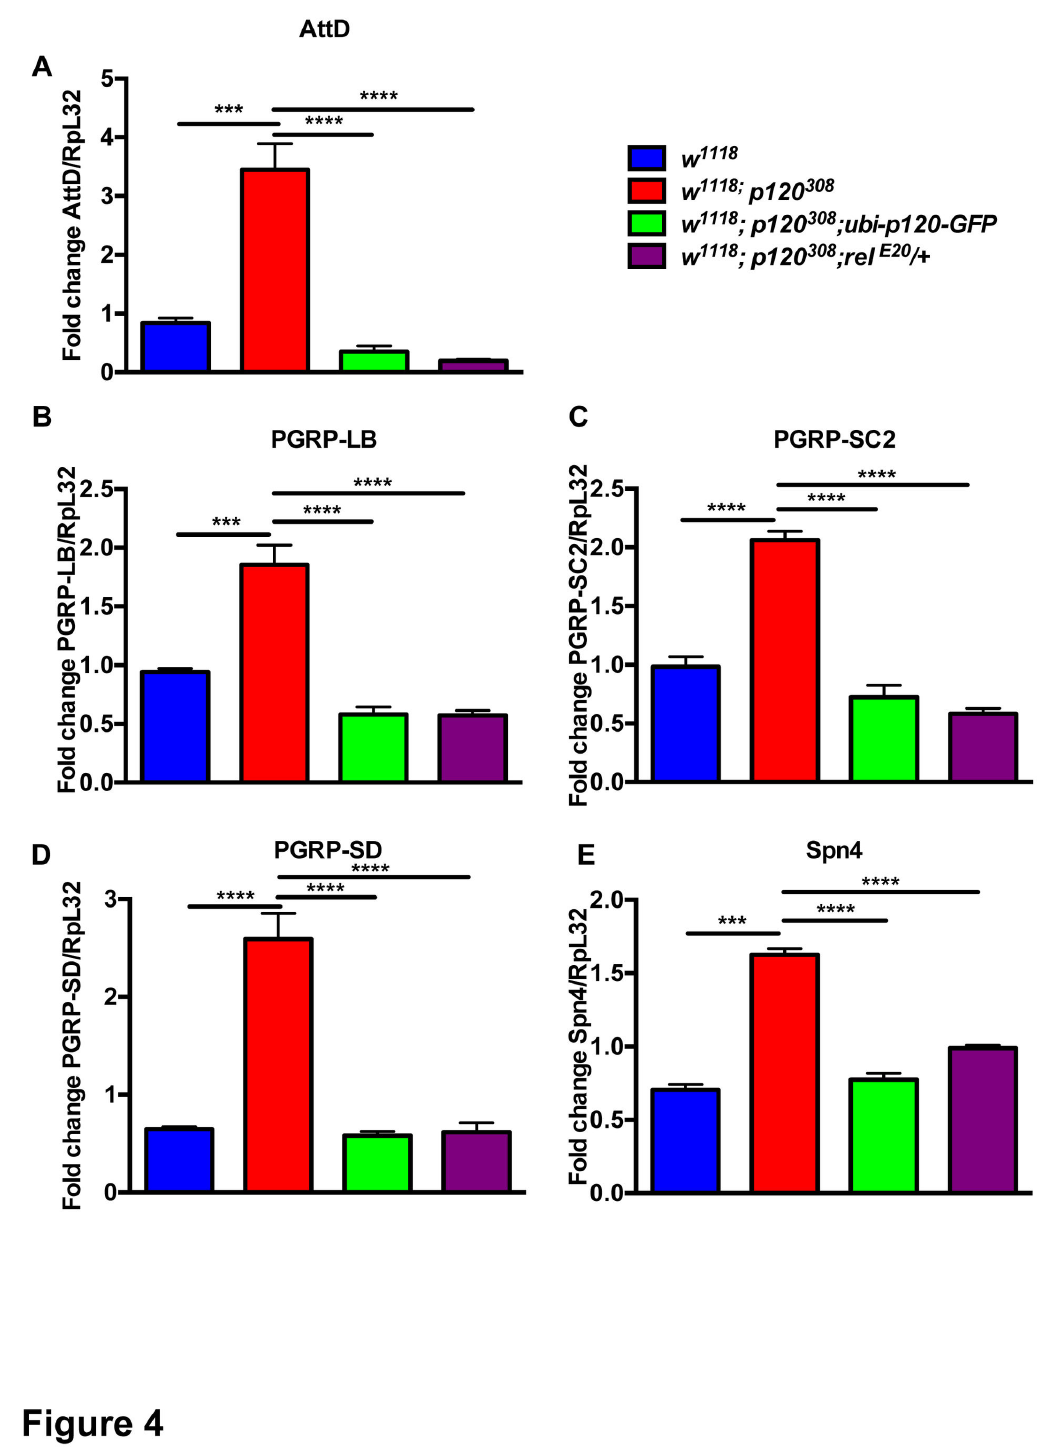
Figure 4. Ubiquitous expression of dp120ctn-GFP or relish heterozygosity rescues aberrant gene expression in dp120ctn mutant flies. (A-E) qPCR analysis of the selected genes in (i) w 1118 , (ii) w 1118 ; p120 308 , (iii) w 1118 ; p120 308 ; ubi-p120-GFP and (iv) w 1118 ; p120 308 ; relE20/ + flies (one-way ANOVA with Bonferroni posttest correction, ***p<0.001****p<0.0001). Note that restoring p120ctn expression or halving the genetic dose of relish rescued the deregulated expression of these genes in dp120ctn mutants. (All error bars denote standard error of the mean). doi: 10.1371/journal.pone.0083942.g004 PLOS ONE |